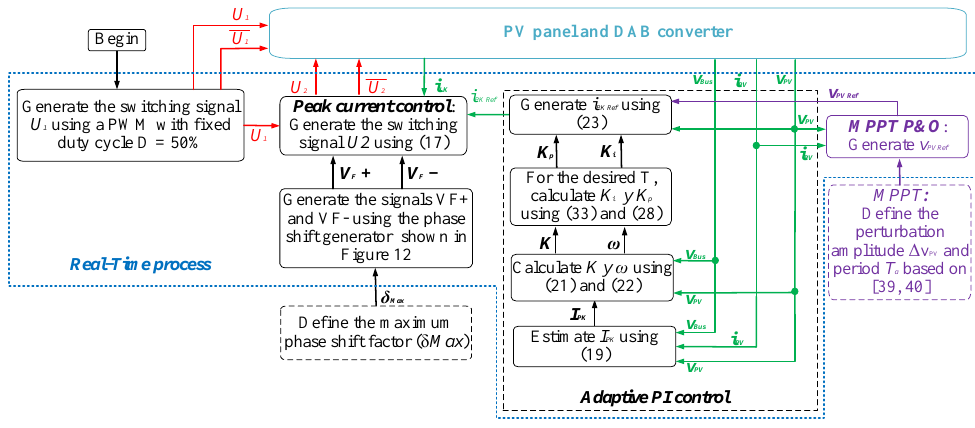
Figure 10. Operation diagram of the proposed control